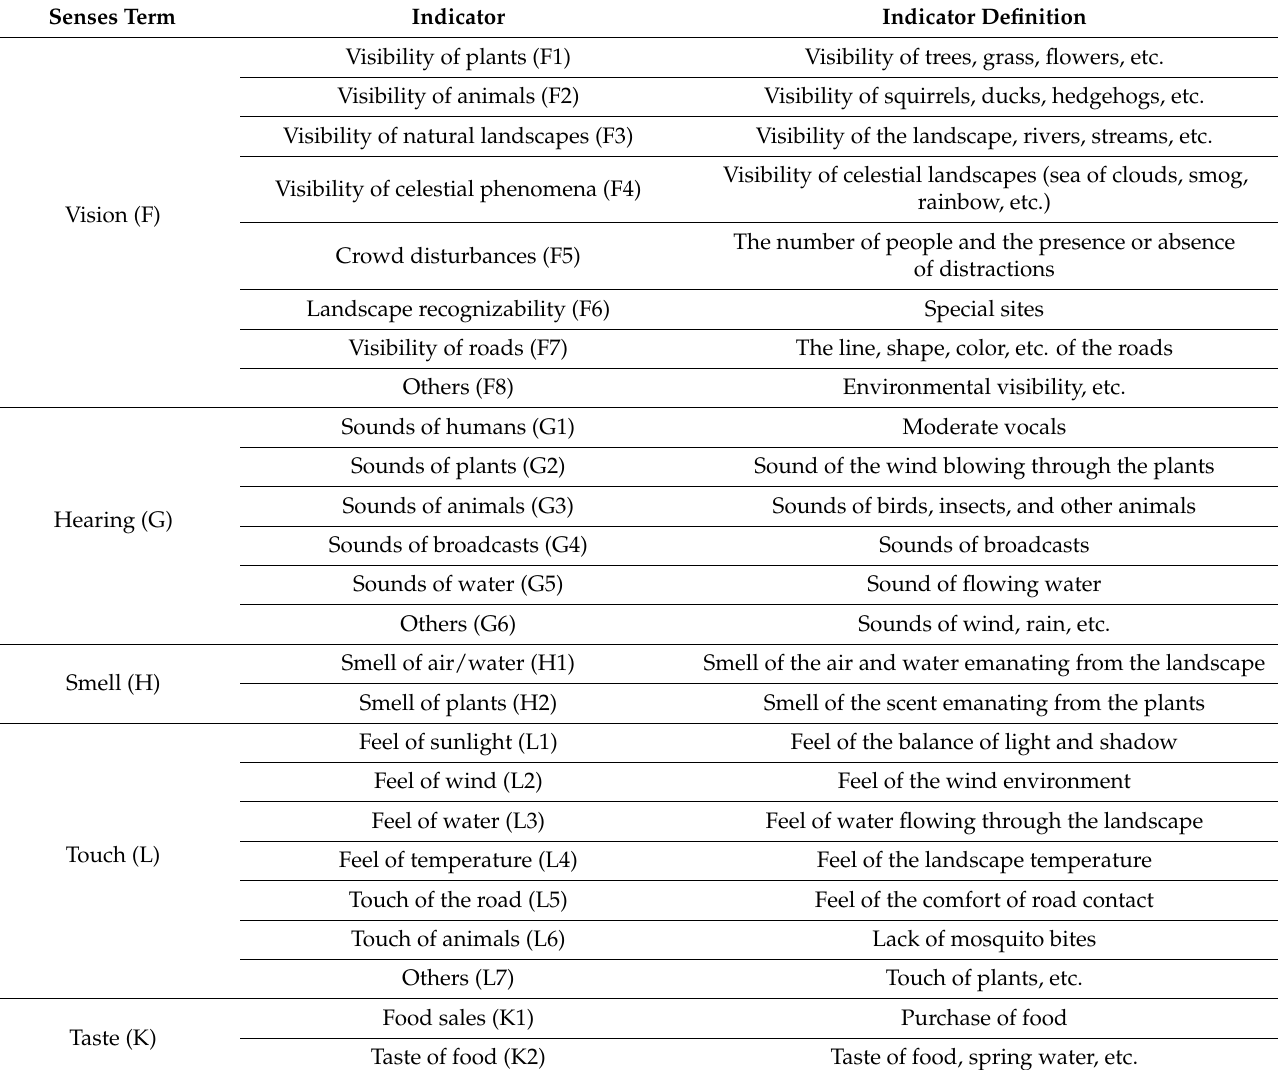
Table 4. Evaluative indexes of the experiences of mountain landscape tourists in terms of the five